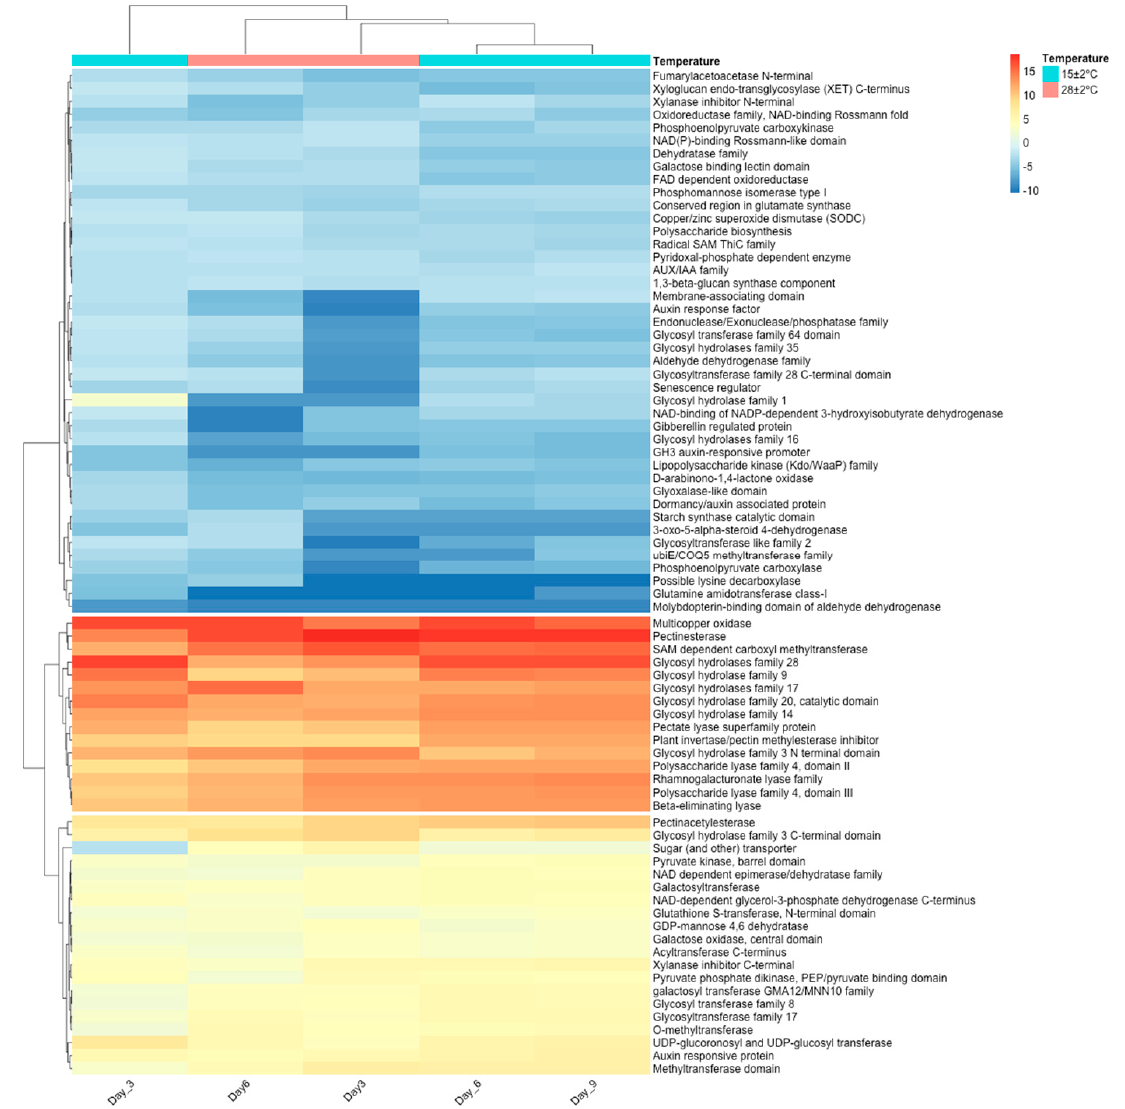
Figure 5. Heatmap of the DEG associated with ripening per day of storage at 28 ± 2 ◦ C and 15 ± 2 ◦ C. The dendrogram shows the relationship between gene expression by hierarchical clustering. The color key indicates the LogFC of the DEG (FDR < 0.001), ranging from blue to